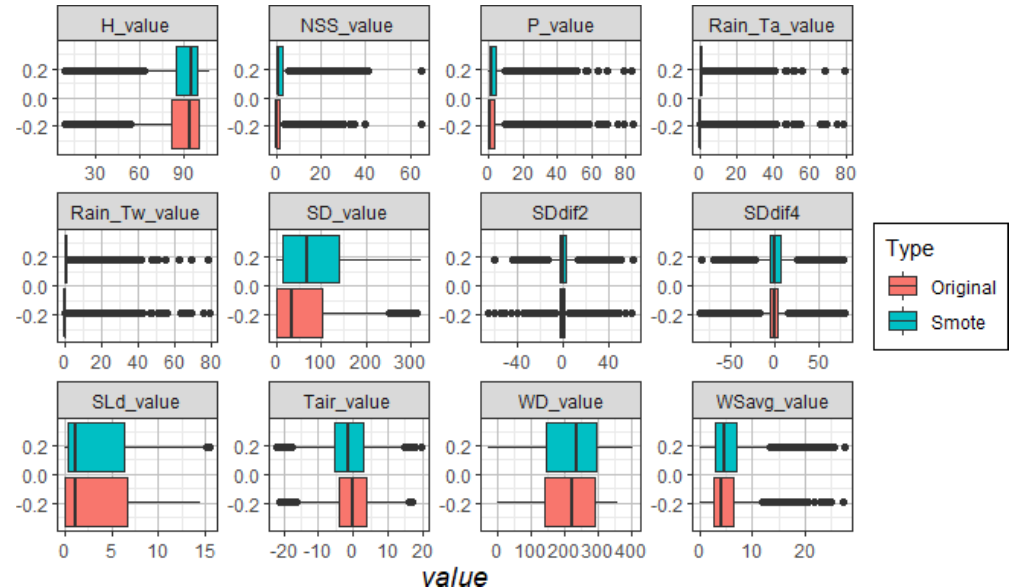
Figure A2. Boxplot of slab avalanches of original and synthetic (SMOTE)